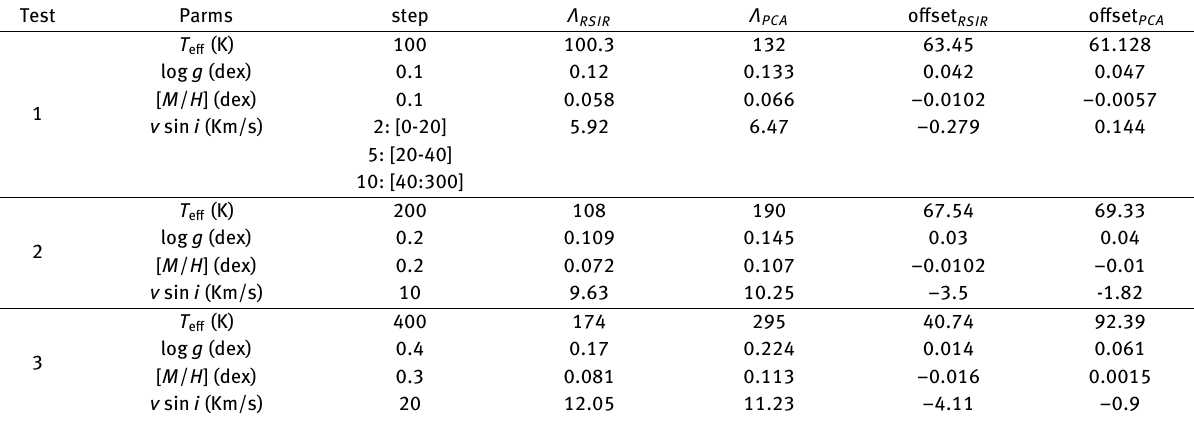
Table 2. Result of inversion for A stars using 3 different LDB with different steps on 1500 noisy synthetic spectra.